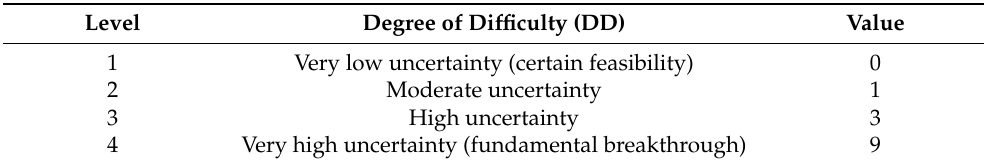
Table 2. Technical Difficulty (adapted from [39]).